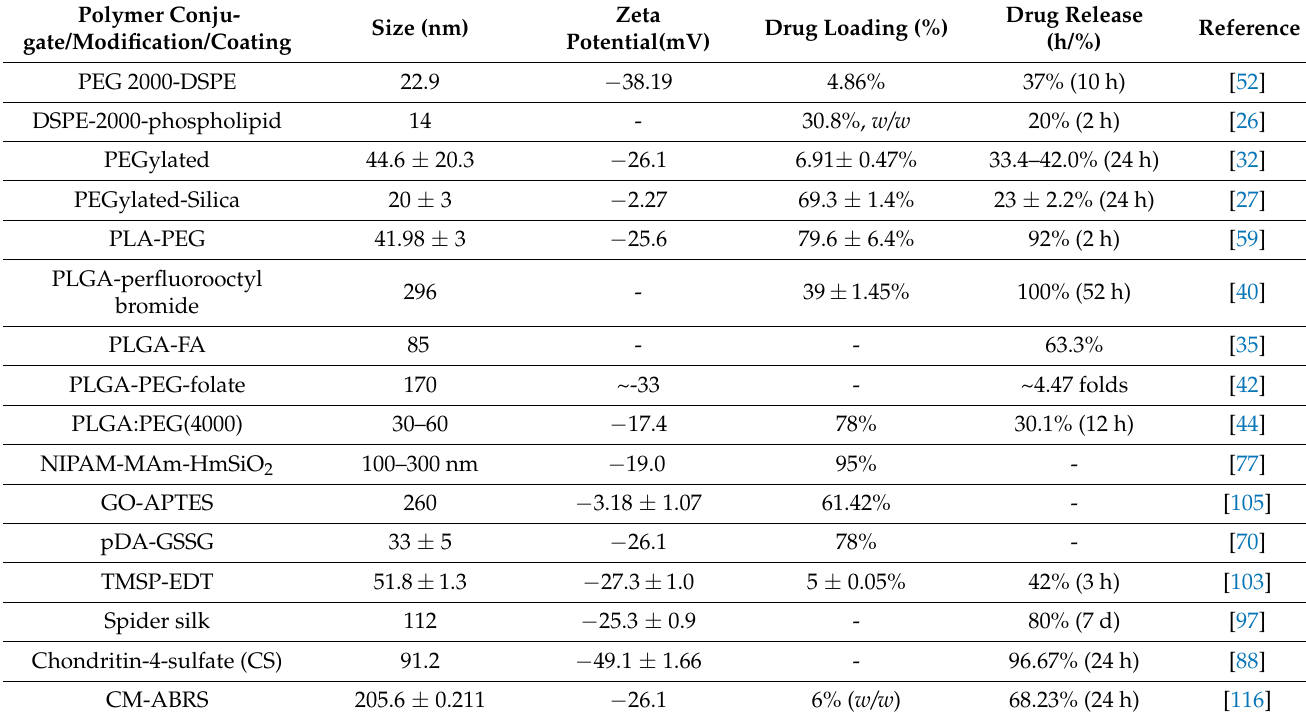
Table 3. Different parameters of the polymeric SPIONs conjugates in the delivery of DOX.